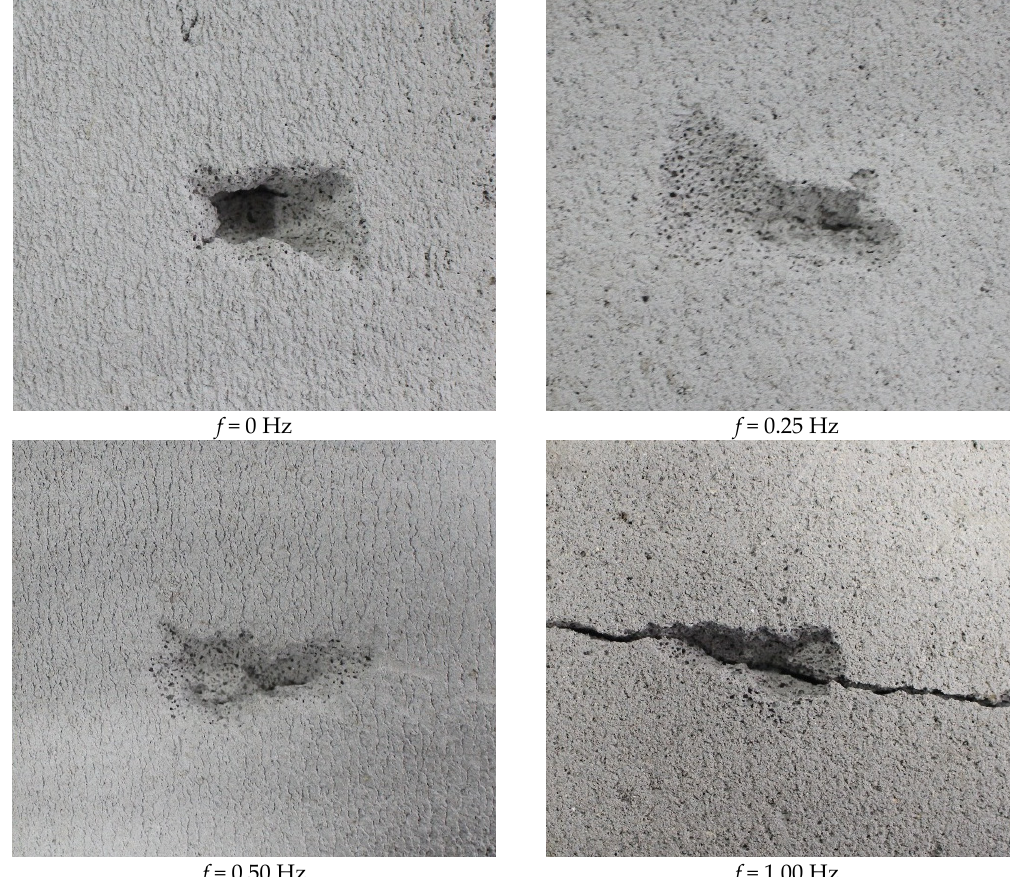
Figure 21. The erosion pattern of specimens under forced excitation (Series 1.0).